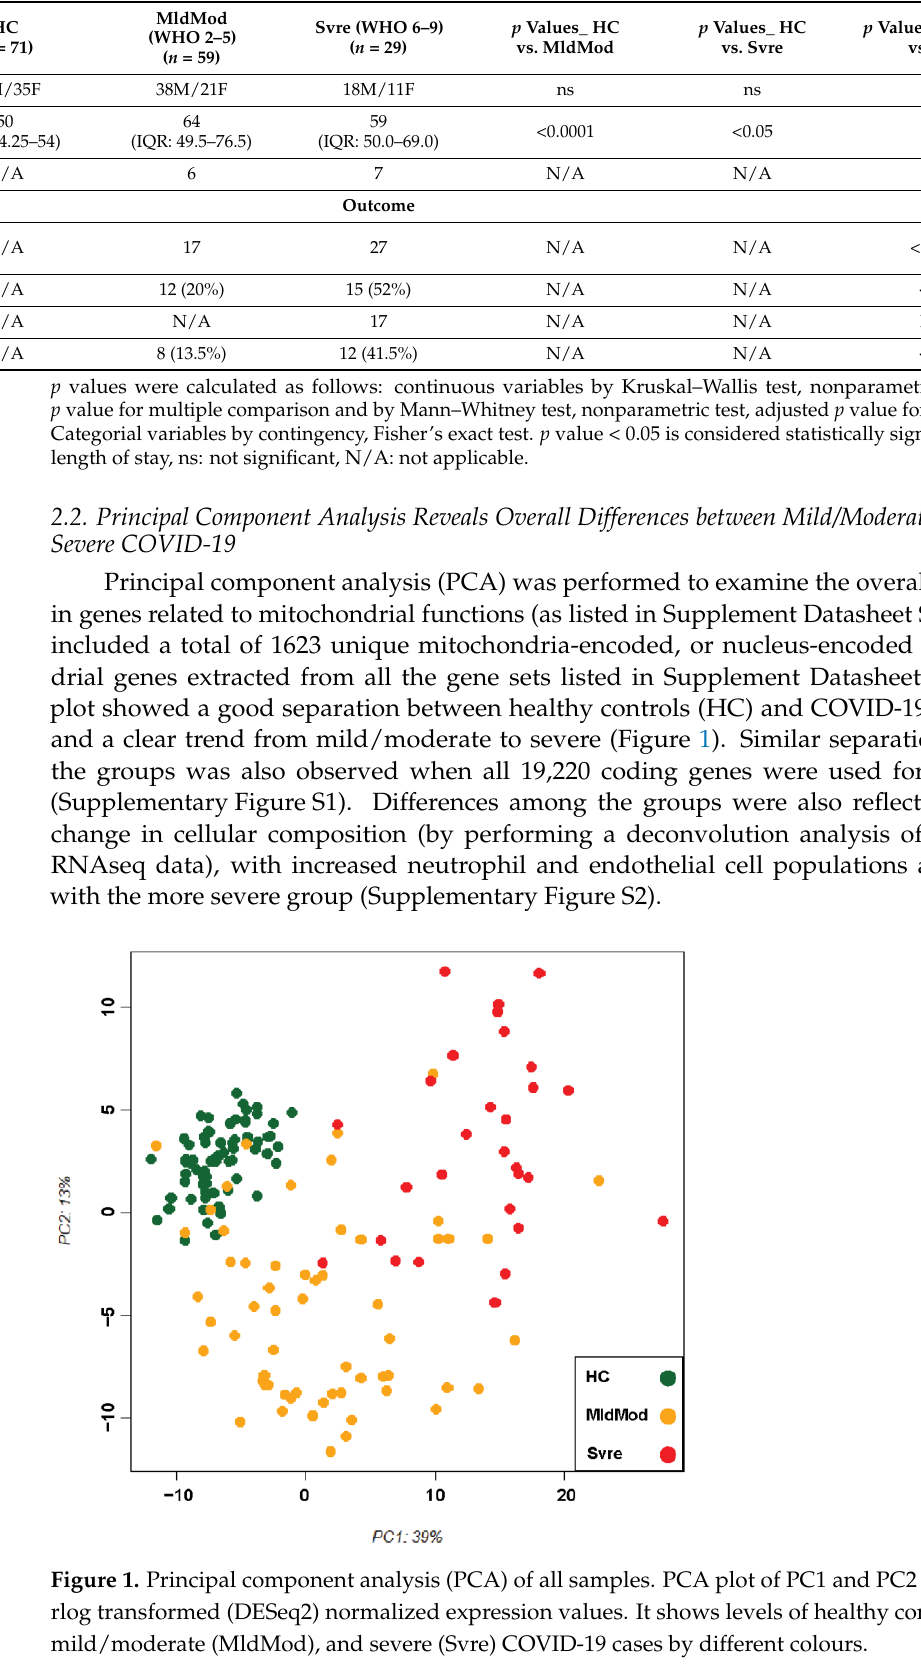
To determine how SARS-CoV-2 infection impacts mitochondrial function or regula- tion in patients with mild/moderate or severe COVID-19, we performed differential ex- pression gene (DEG) analysis on the selected genes ( n = 1623 genes) (Supplemental Datasheet S2). When compared to healthy controls, there were 67 up- and 13 downregu- lated DEGs in the mild/moderate group and 210 up- and 67 downregulated DEGs in the severe group (Figure 2A). There were 104 up- and 42 downregulated DEGs in the severe group compared to the mild/moderate one. Figure 2B,C show the unique or overlapping up- or downregulated DEGs in the severe or the mild/moderate group compared to the healthy control, respectively. Figure 2D – F, show the top 20 up- or downregulated genes for each comparison group respectively, namely mild/moderate vs. healthy control, se- vere vs. healthy control, and severe vs. mild/moderate. Figure 2. DEGs from comparisons of severity groups. ( A ) Bar diagram showing the number of up- (in blue) and downregulated (in red) DEGs from three comparisons: mild/moderate versus healthy controls (MldMod vs. HC); severe versus healthy control (Svre vs HC), and severe versus mild/mod- erate (Svre vs. MldMod). Y axis: number of DEGs. ( B ) Venn diagram showing the number of over- lapping or nonoverlapping upregulated DEGs between comparison MldMod vs. HC (purple) and comparison Svre vs HC (red). ( C ) Venn diagram showing the number of overlapping or nonover- lapping downregulated DEGs between comparison MldMod vs. HC (dark blue) and comparison Svre vs. HC (light blue). ( D – F ) Volcano plots showing the significantly up- or downregulated DEGs (red) (with adjusted p -value of <0.05 and an absolute 1.5-fold ([log 2 ] > 0.58) difference in expression levels) in the three comparisons as in ( A ), respectively. Name of the top 20 significantly up- or down- regulated DEGs were shown. 2.4. Pathway Enrichment Analysis Reveals Regulation or Dysregulation of Pathways Associated with Mild/Moderate or Severe COVID-19